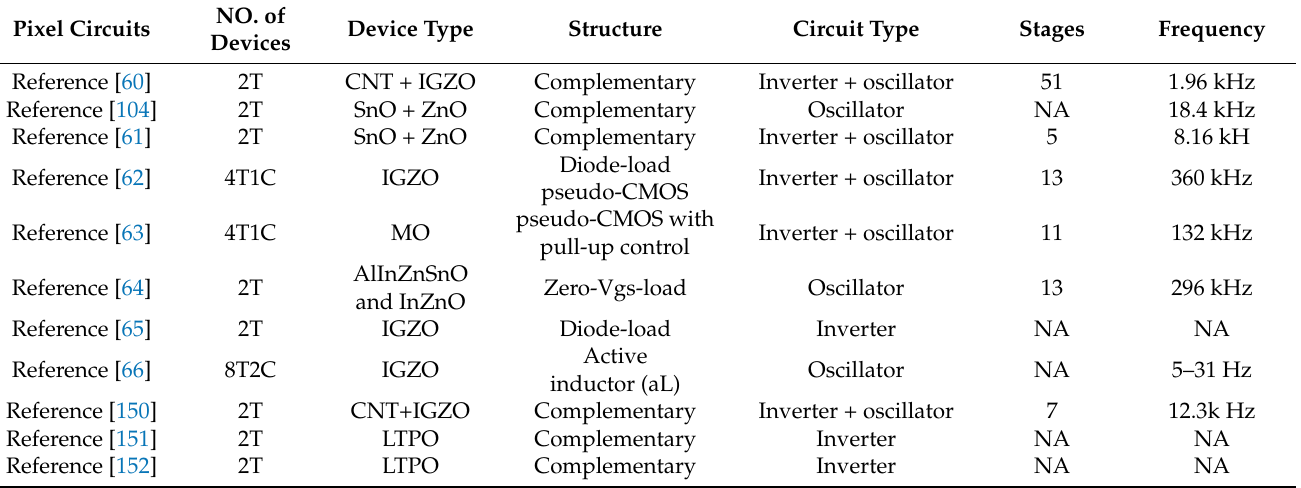
Table 2. Summarized performances for the representative inverter and oscillator of oxide-based TFTs. Pixel Circuits Structure Circuit